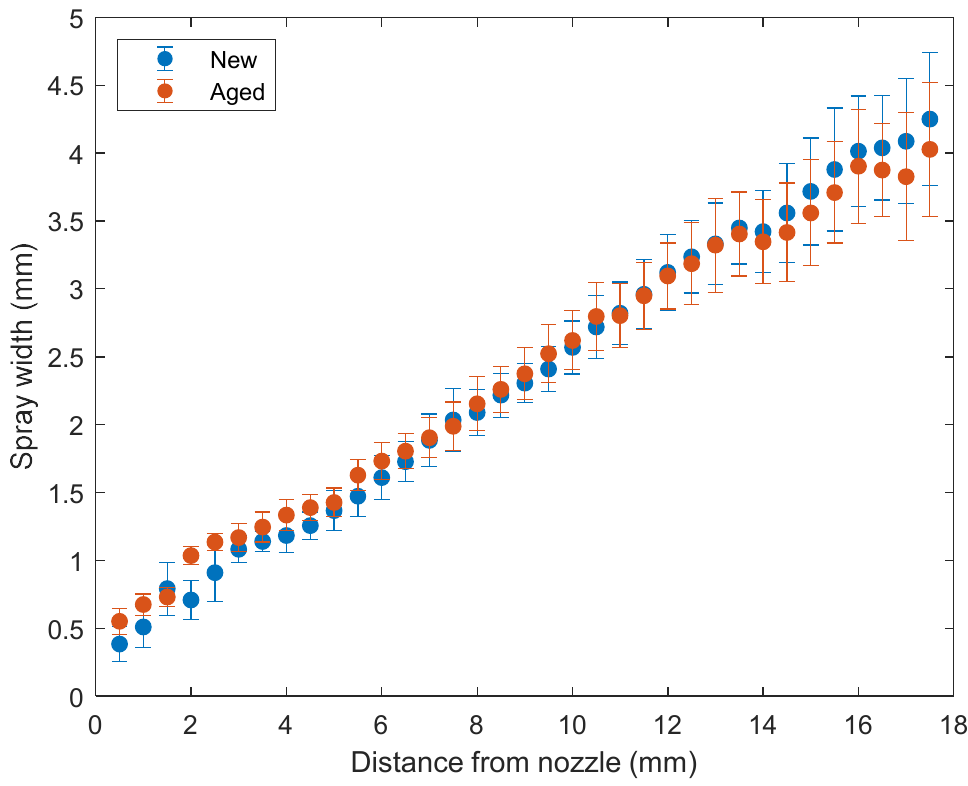
Figure 16. Width comparison at medium load when using the new and the aged injector.